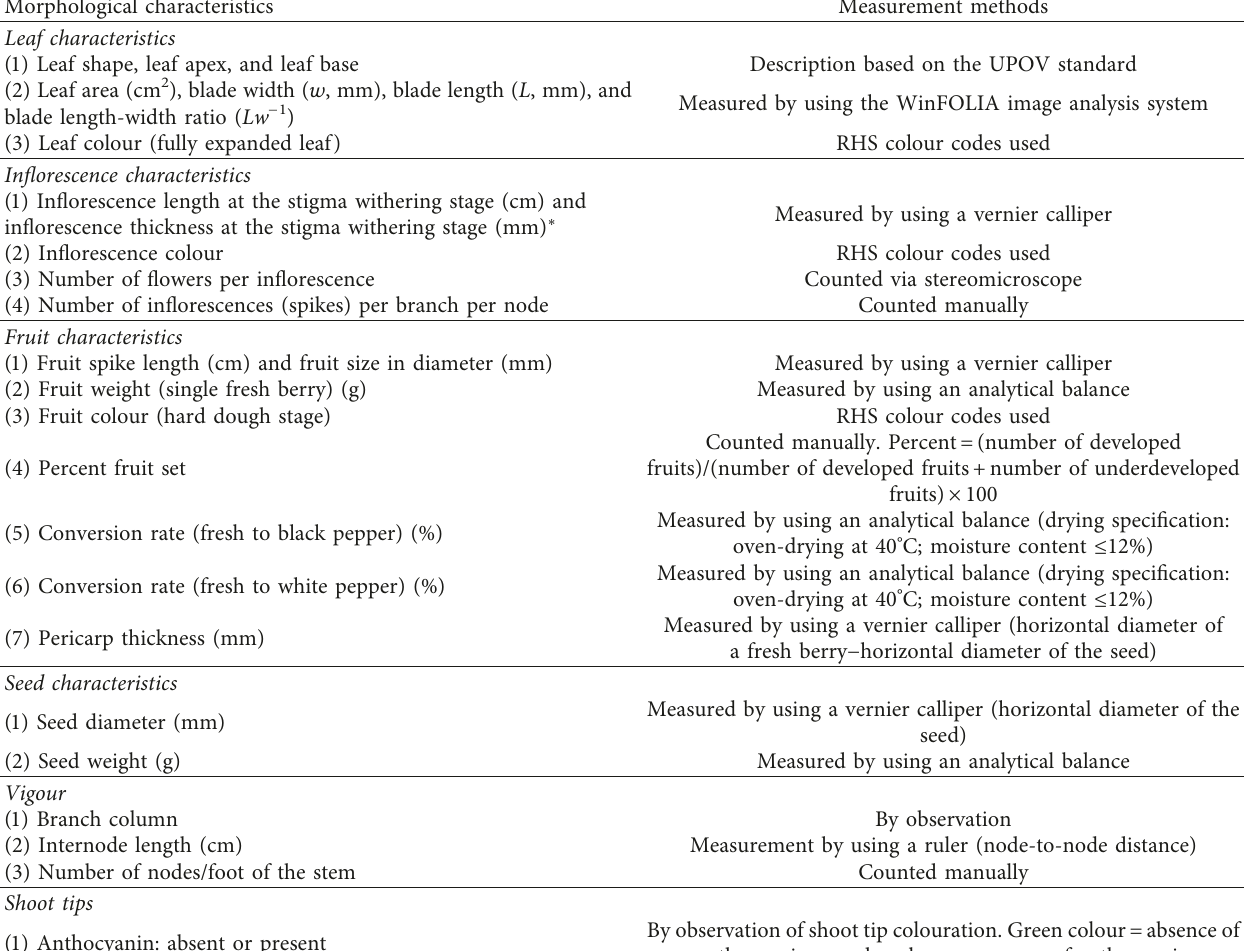
Table 1: Morphological characteristics used in the phenetic analysis of black pepper